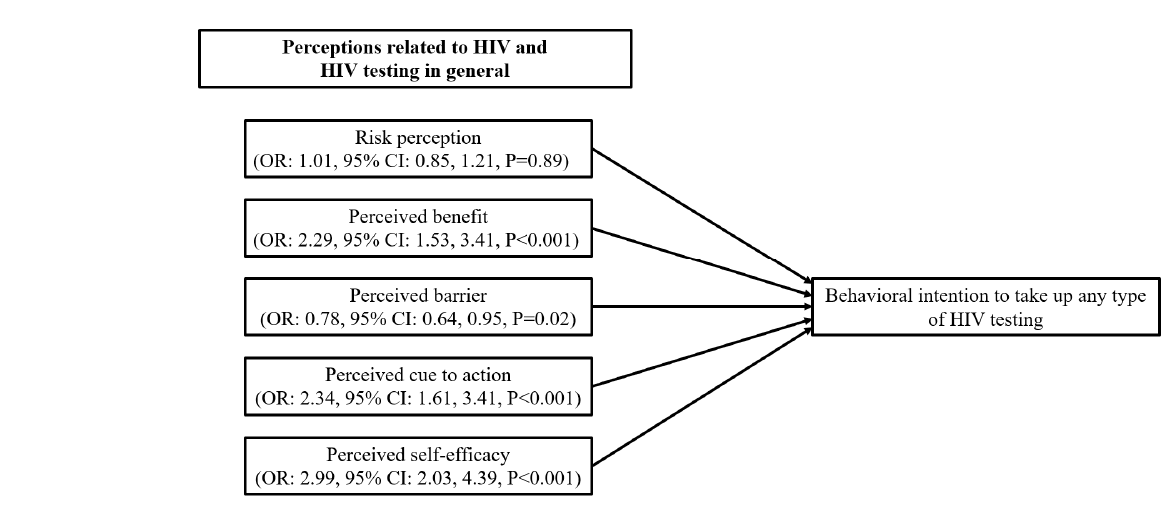
Figure 2. Factors associated with behavioral intention to take up HIVST. 4. Discussion This is one of the first studies examining behavioral intention to take up any type of HIV testing and HIVST and the associated factors among migrant male factory workers in China. Factors at the individual and interpersonal levels as determinants of HIV testing were considered. The findings provided a knowledge basis to develop tailored behavioral interventions to increase the uptake of HIV testing among migrant male factory workers. The lifetime uptake of any type of HIV testing (16.5% vs. 60.5%) and HIVST (12.7% vs. 26.2%) among high-risk migrant workers was much lower than that of MSM in China [58,59]. Moreover, less than one quarter of the study sample intended to take up any type of HIV testing or HIVST in future. There is hence much room for improvement. Some factors may contribute to the discrepancy in lifetime uptake and low behavioral intentions between male migrant workers and MSM. First, according to previous research, many migrant workers lacked HIV/STI-related knowledge., and about 40% did not know that